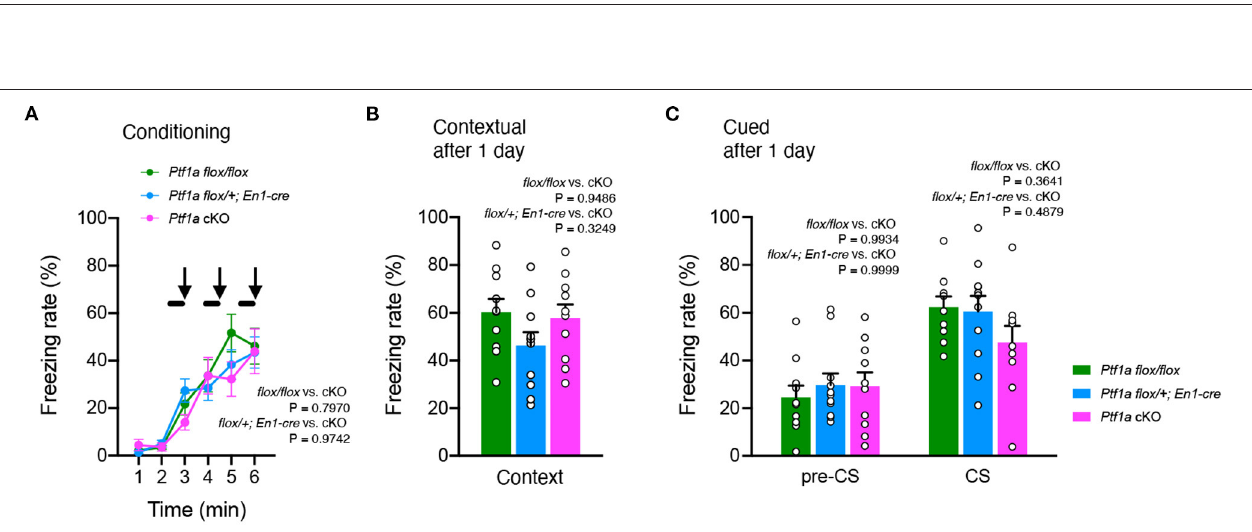
Frontiers in Behavioral Neuroscience | www.frontiersin.org